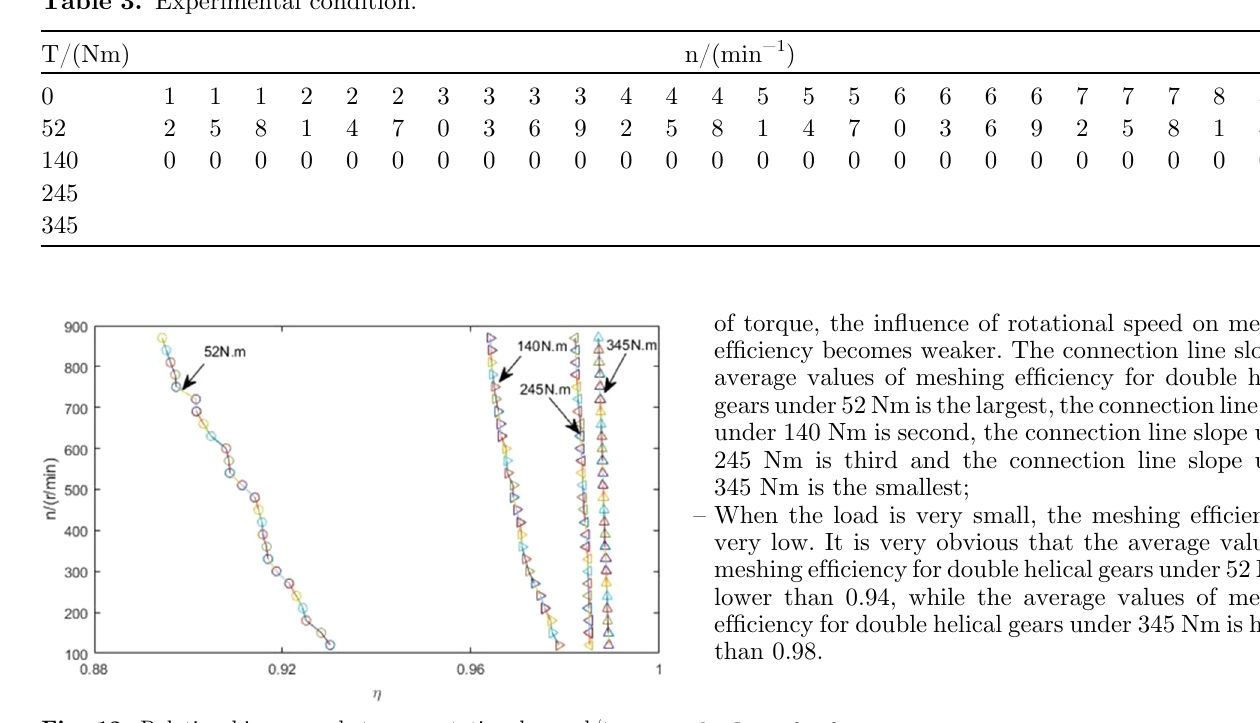
Fig. 12. Relationship curve between rotational speed/torque and meshing ef fi ciency of double helical